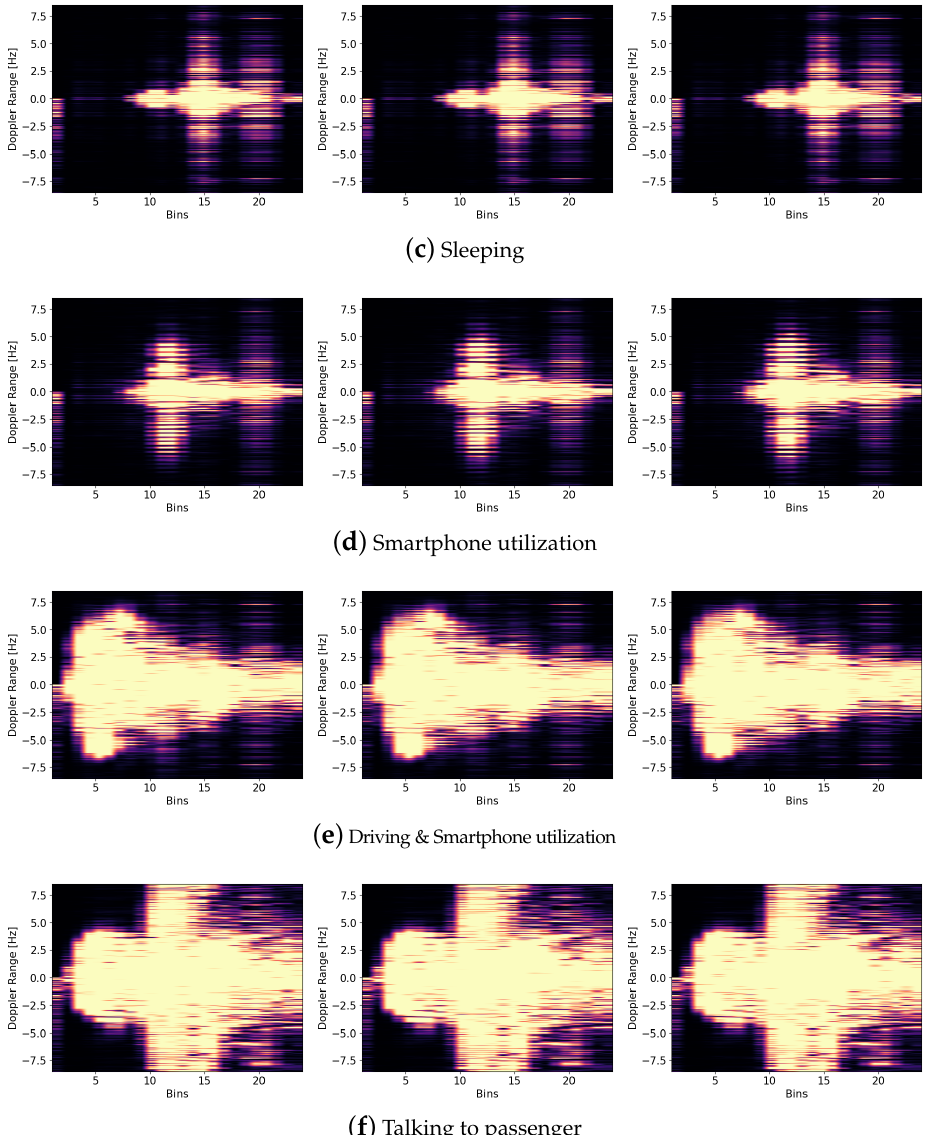
Figure 4. Range-Doppler spectrograms of six ( a – f ) in-cabin activities captured by the radar. Three images within one class represent roughly one second.